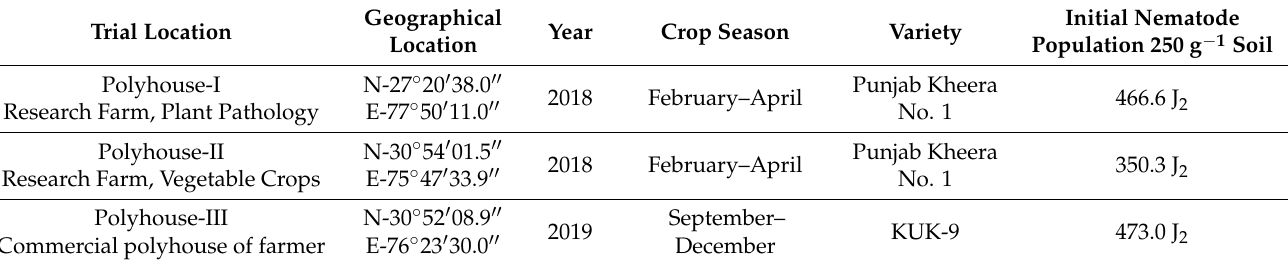
Table 1. The details of the experimental trials at different